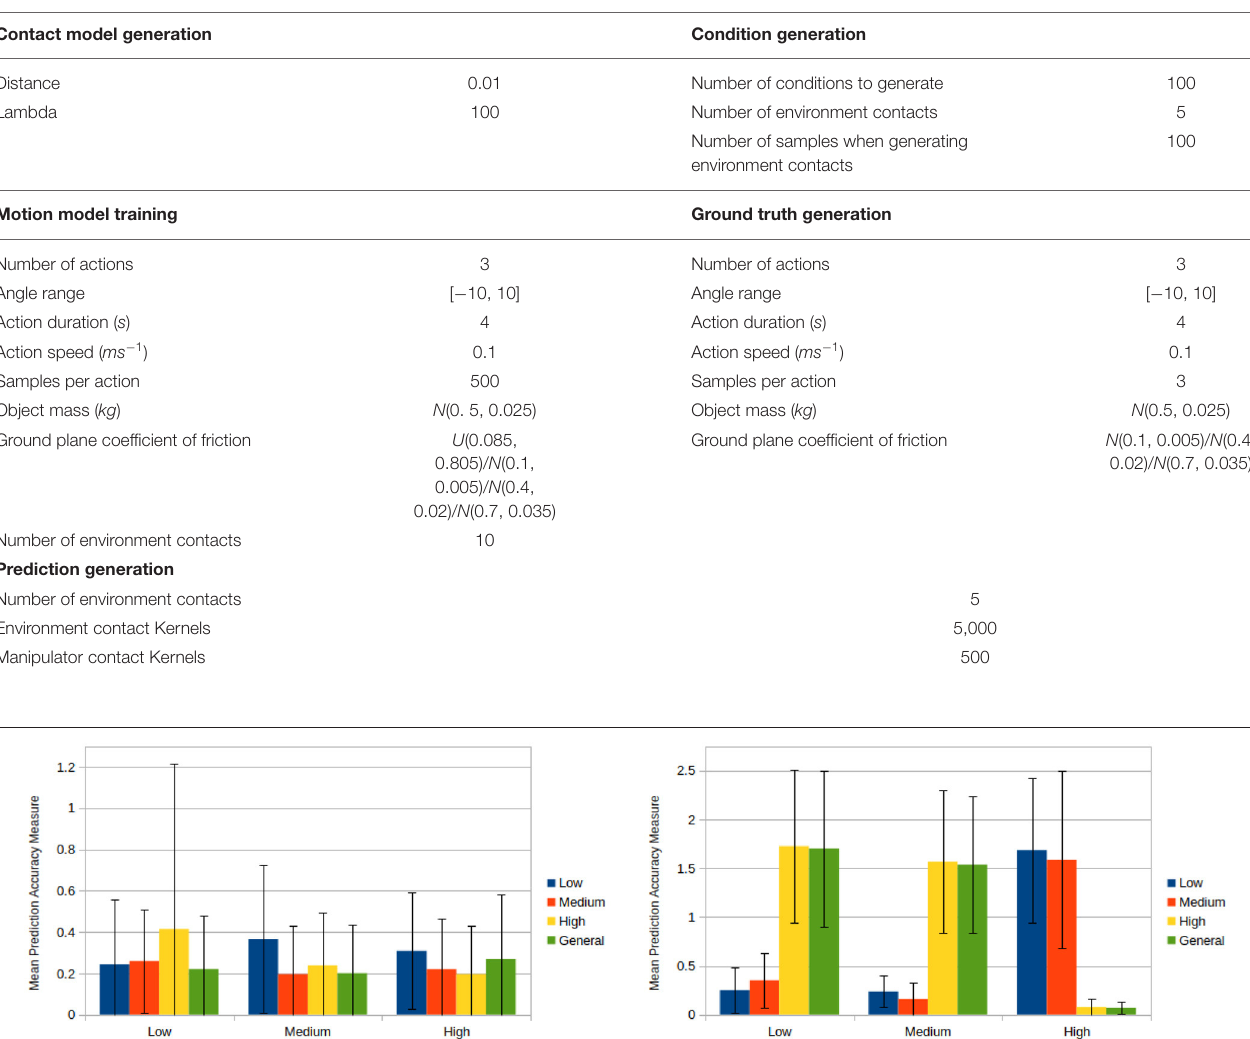
TABLE 5 | Experimental parameters for evaluating the prediction accuracy on novel objects (section 8.3) under various friction biasing conditions. Contact model generation